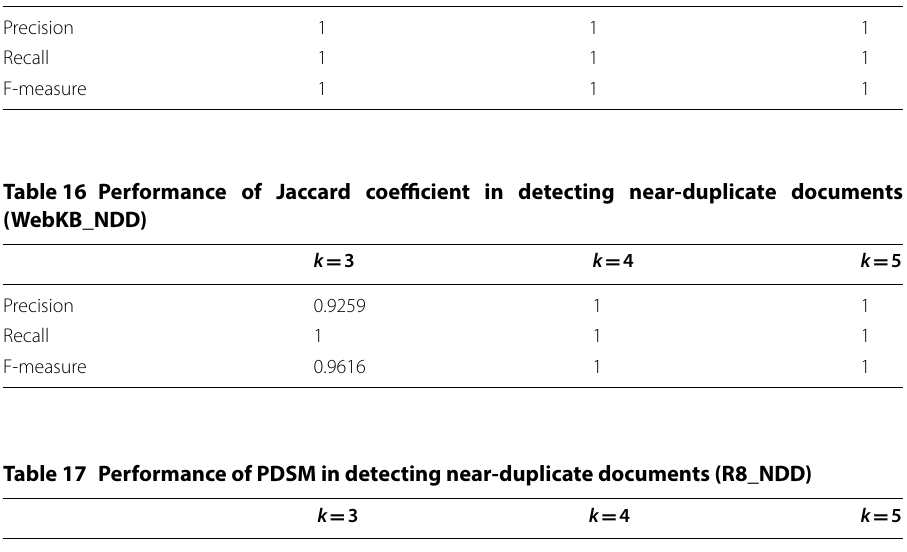
Table 15 Performance of PDSM in detecting near-duplicate documents (WebKB_NDD) k 3 k 4 k 5 = = = Precision 1 1 1 Recall 1 1 1 F-measure 1 1 1